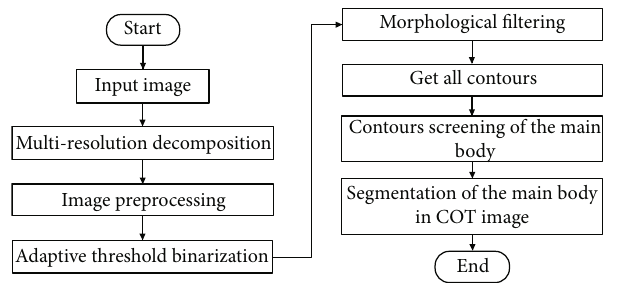
Figure 3: Flowchart of the body in COT image extraction